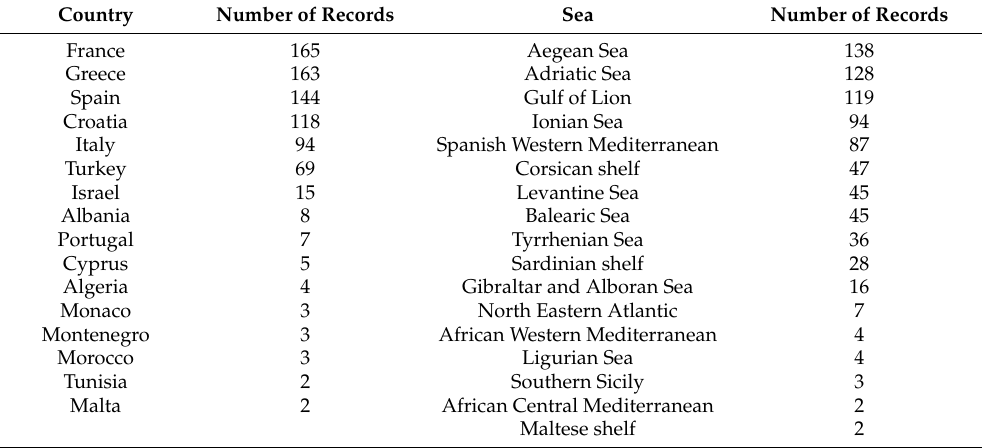
Table 1. Number of records of G. incognitus per country and per sea